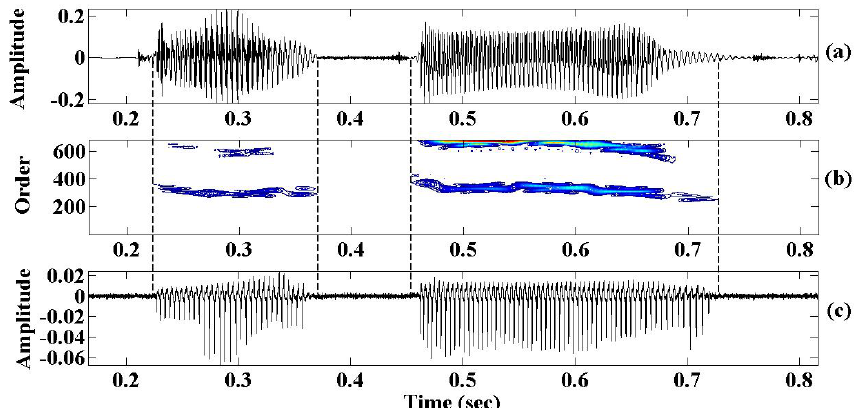
Figure 1. (a) Speech signal segment. (b) Energy distribution of speech signal seg- ment in the time-order plane for LFR. (c) DEGG signal. Reference voiced regions are shown by dashed lines. Speech signal is taken from the CMU-Arctic database with speaker id